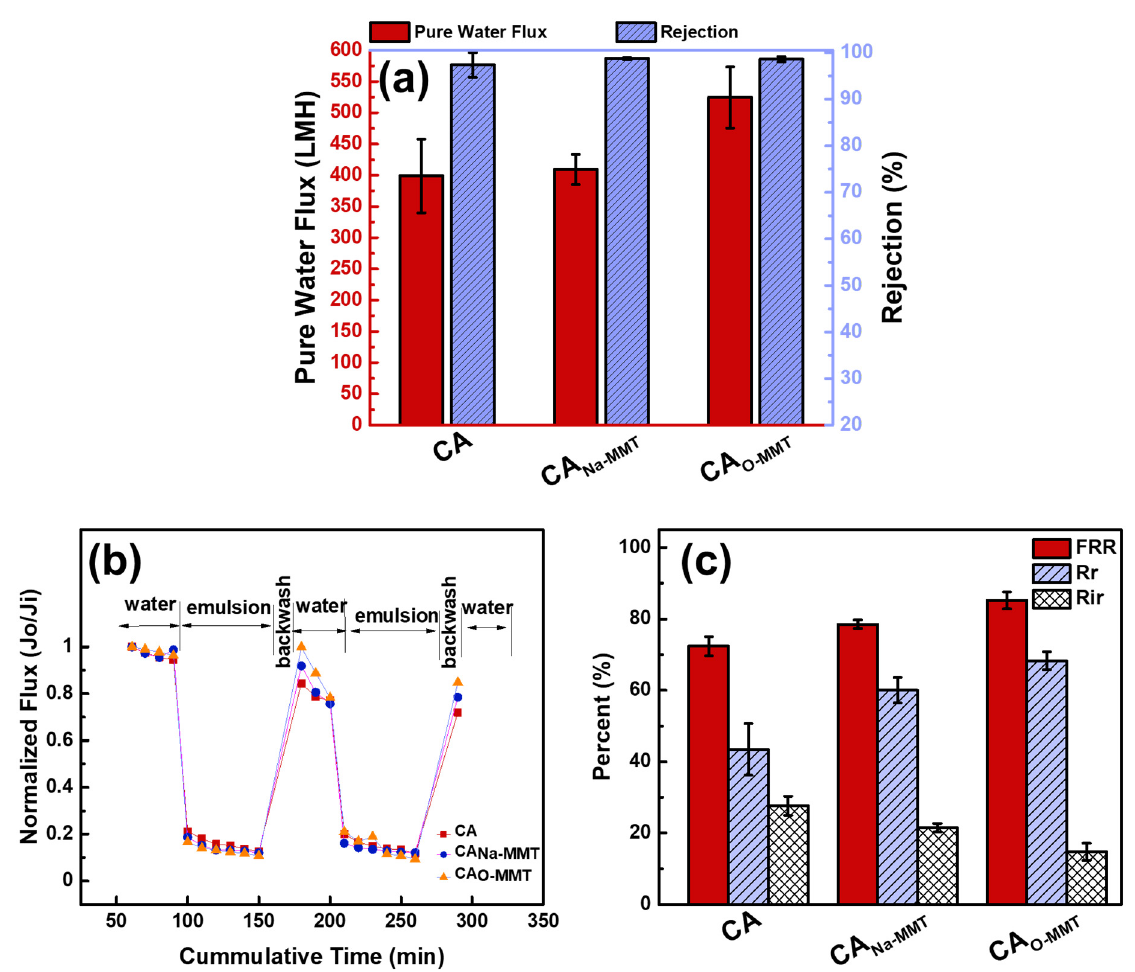
Figure 5. ( a ) Membrane performance and ( b , c ) antifouling property of CA, CA Na-MMT , and CA O-MMT .